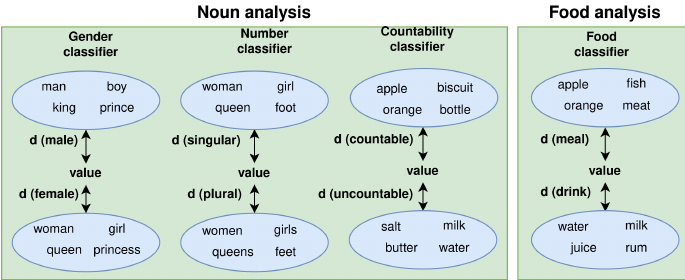
Figure 8. Noun and Food analysis for the GROWsetta process.